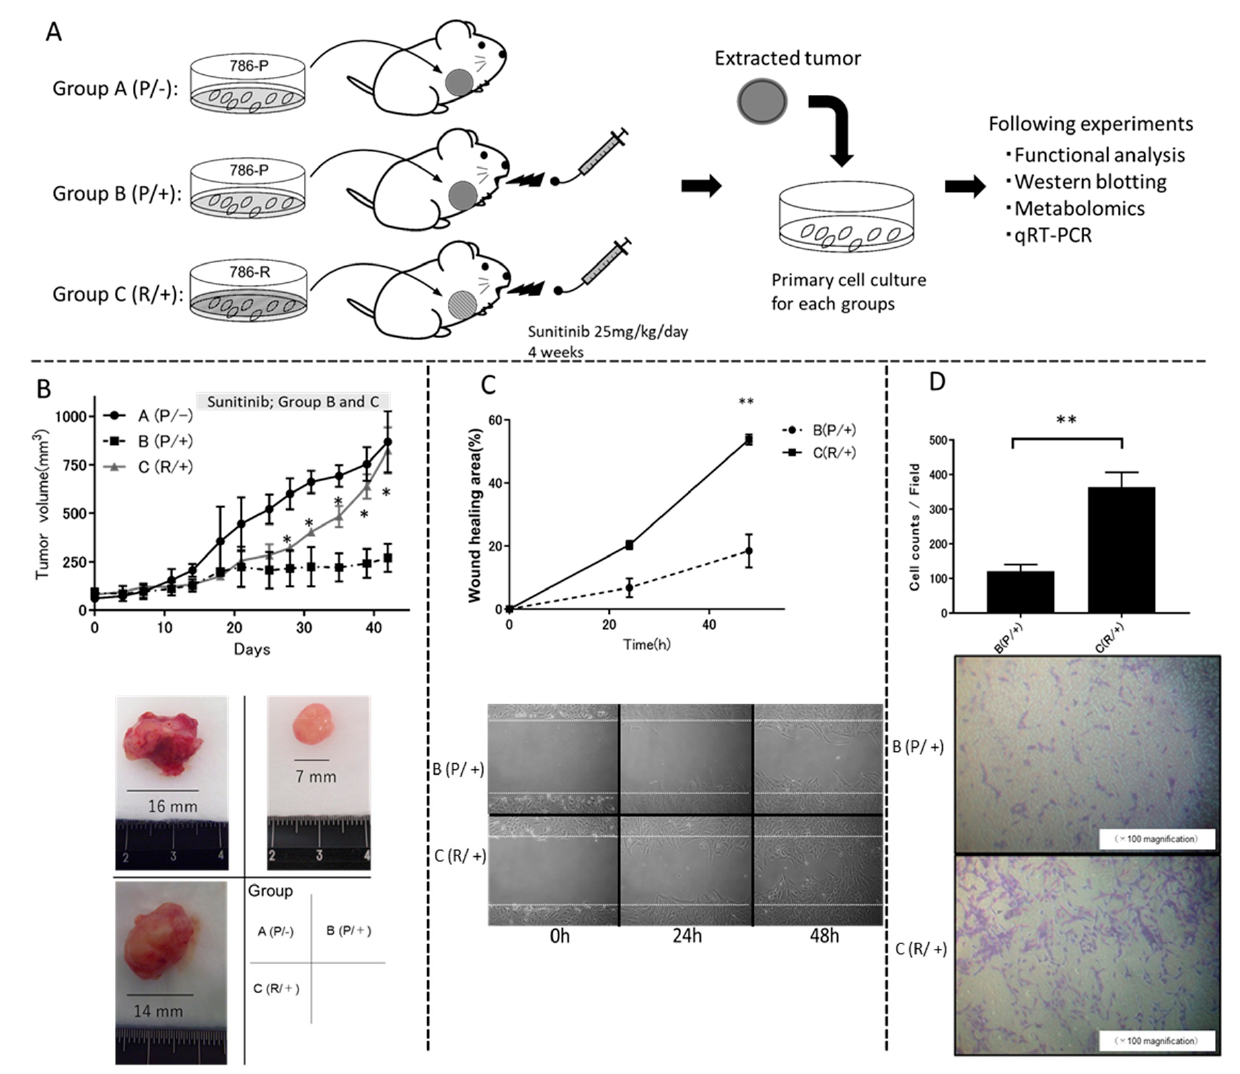
Figure 2. Establishment of sunitinib-resistant cells and cell profiles: ( A ) Three experimental mouse groups were created (n = 5/group): group A (P/ − ), 2 × 10 6 786-P cells were transplanted and sunitinib was not orally administered; group B (P/+), 2 × 10 6 786-P cells were transplanted and sunitinib was orally administered; and group C (R/+), 2 × 10 6 786-R cells were transplanted and sunitinib was orally administered. Sunitinib dose was 25 mg/kg/day. ( B ) Group C (R/+) showed a significant increase in tumor volume compared with group B (P/+) after 15 days of sunitinib treatment. Tumor volume was calculated using the modified ellipsoid formula 1/2 (length × width 2 ) after transplantation. ( C ). In the wound healing assay, the migration area was calculated every 24 h under exposure to sunitinib. The ratio of the migration area to the scratch area was graphed. Group C (R/+) showed increased migration ability compared with group B (P/+) at 48 h after sunitinib exposure ( p = 0.003). The experiment was carried out in triplicate and repeated three times. ( D ) In the two-chamber assay, group C (R/+) demonstrated significantly increased invasion ability under sunitinib exposure compared with group B (P+). The cells that invaded through the membrane to the lower surface were counted. The experiment was carried out in triplicate and repeated three times. Data of ( B – D ) are shown as mean ± standard deviation. Data of ( B – D ) were analyzed for statistical significance by the Mann–Whitney U test. * p < 0.05 ** p <